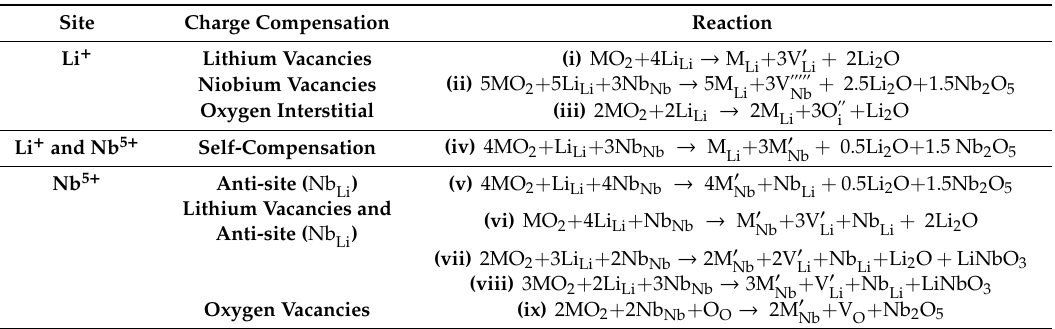
Table 6. Types of defects considered due to M = V 4+ incorporation in LiNbO 3 .